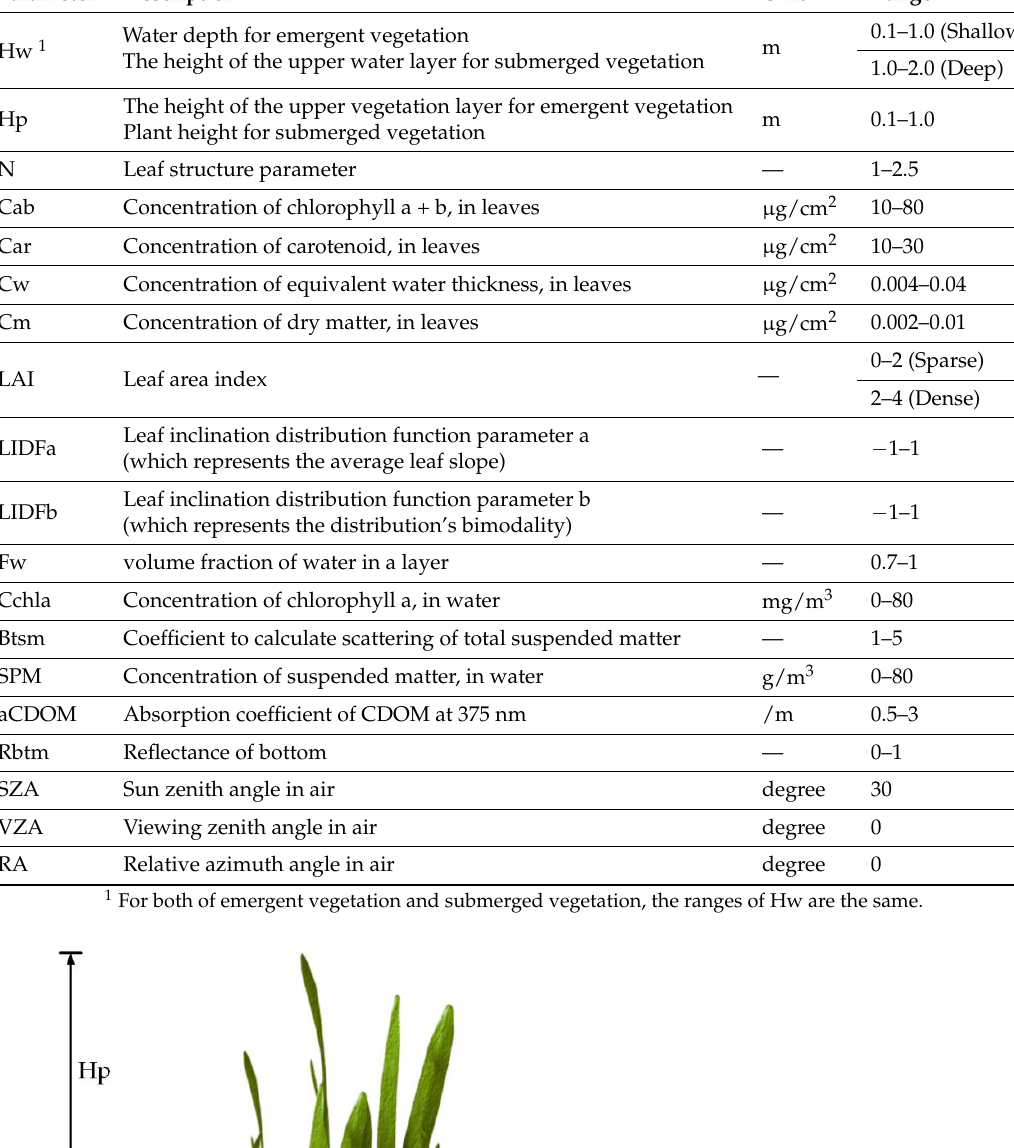
Table 1. The descriptions and ranges of input parameters. The observation conditions are indicated at the end of Table 1, which include solar and viewing zenith angle and the relative azimuth angle in air. Parameter